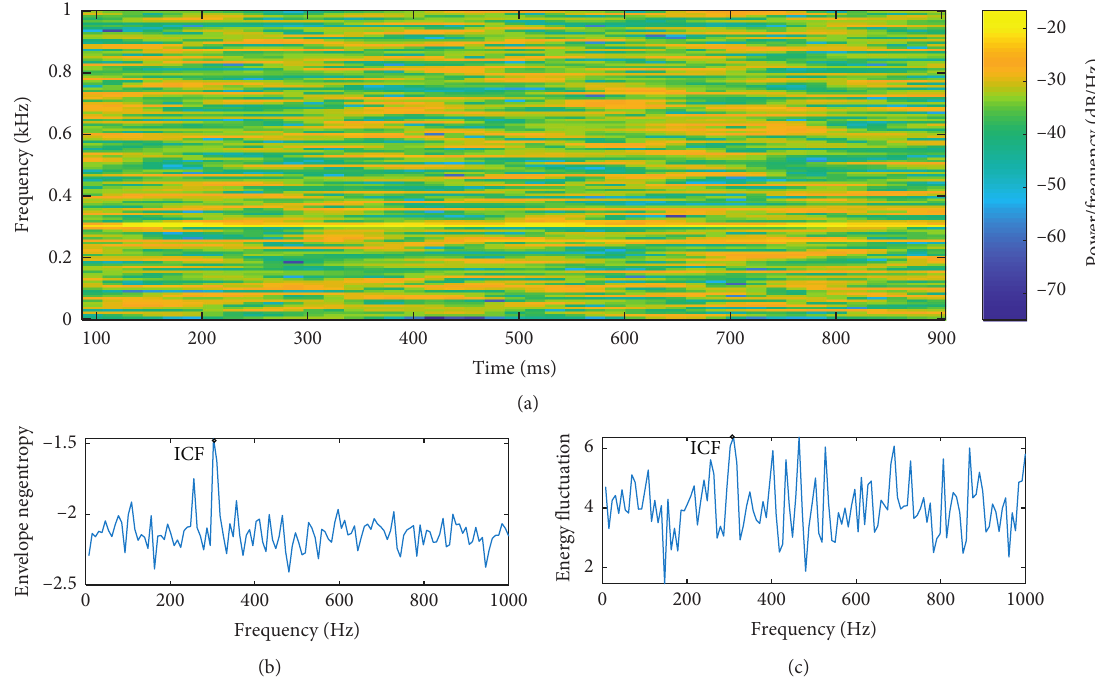
Figure 5: Spectral analysis of the simulated signal in Figure 2(b) at window length 384 and overlap rate 90%: (a) TFR, (b) ENS, (c) EFS.